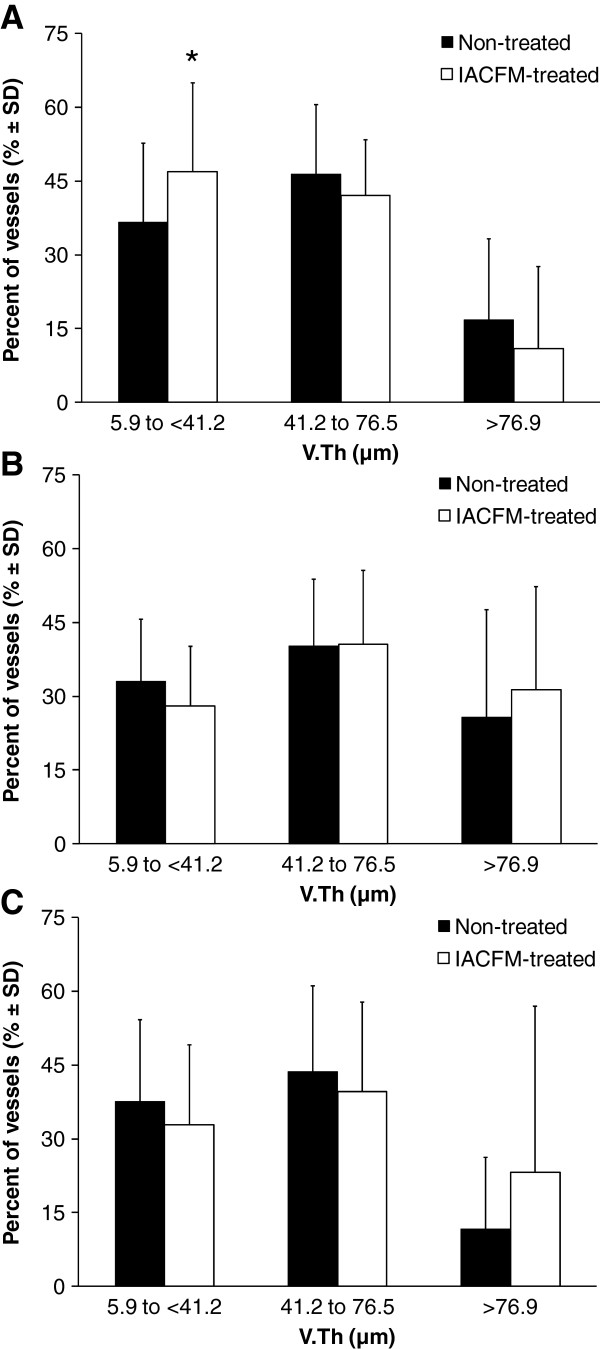
Effect of IACFM on the frequency distribution of vessel thickness (V.Th). V.Th distribution in the A: tibial, B: middle, and C: femoral subregions of the injured knee MCL and adjacent connective tissue. IACFM-treated hindlimbs had a higher proportion of V.Th within the 5.9 to <41.2 μm range in the tibial subregion. No differences were found in the middle or femoral subregions. Bars represent mean ± SD. *indicates p < 0.02 compared to non-treated hindlimb.